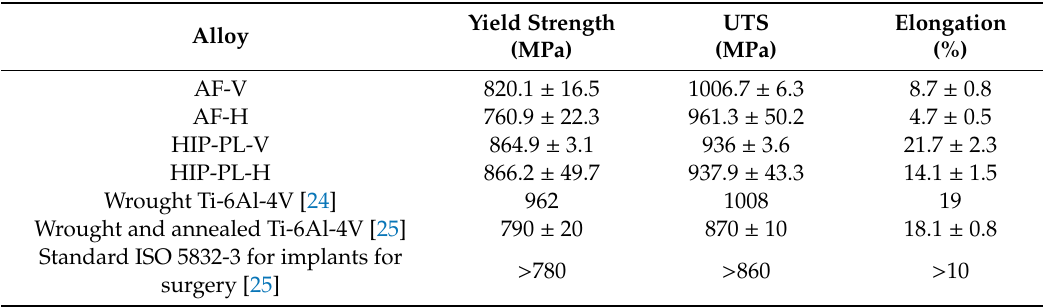
Table 1. Comparison of the tensile properties of SLM Ti-6Al-4V produced in this study built in the as-fabricated (AF) and post-processed with HIP and polishing (PL) in two orientations of vertical (V) and horizontal (H) with wrought Ti-6Al-4V, wrought and annealed Ti-6Al-4V, and the ISO standard available in the